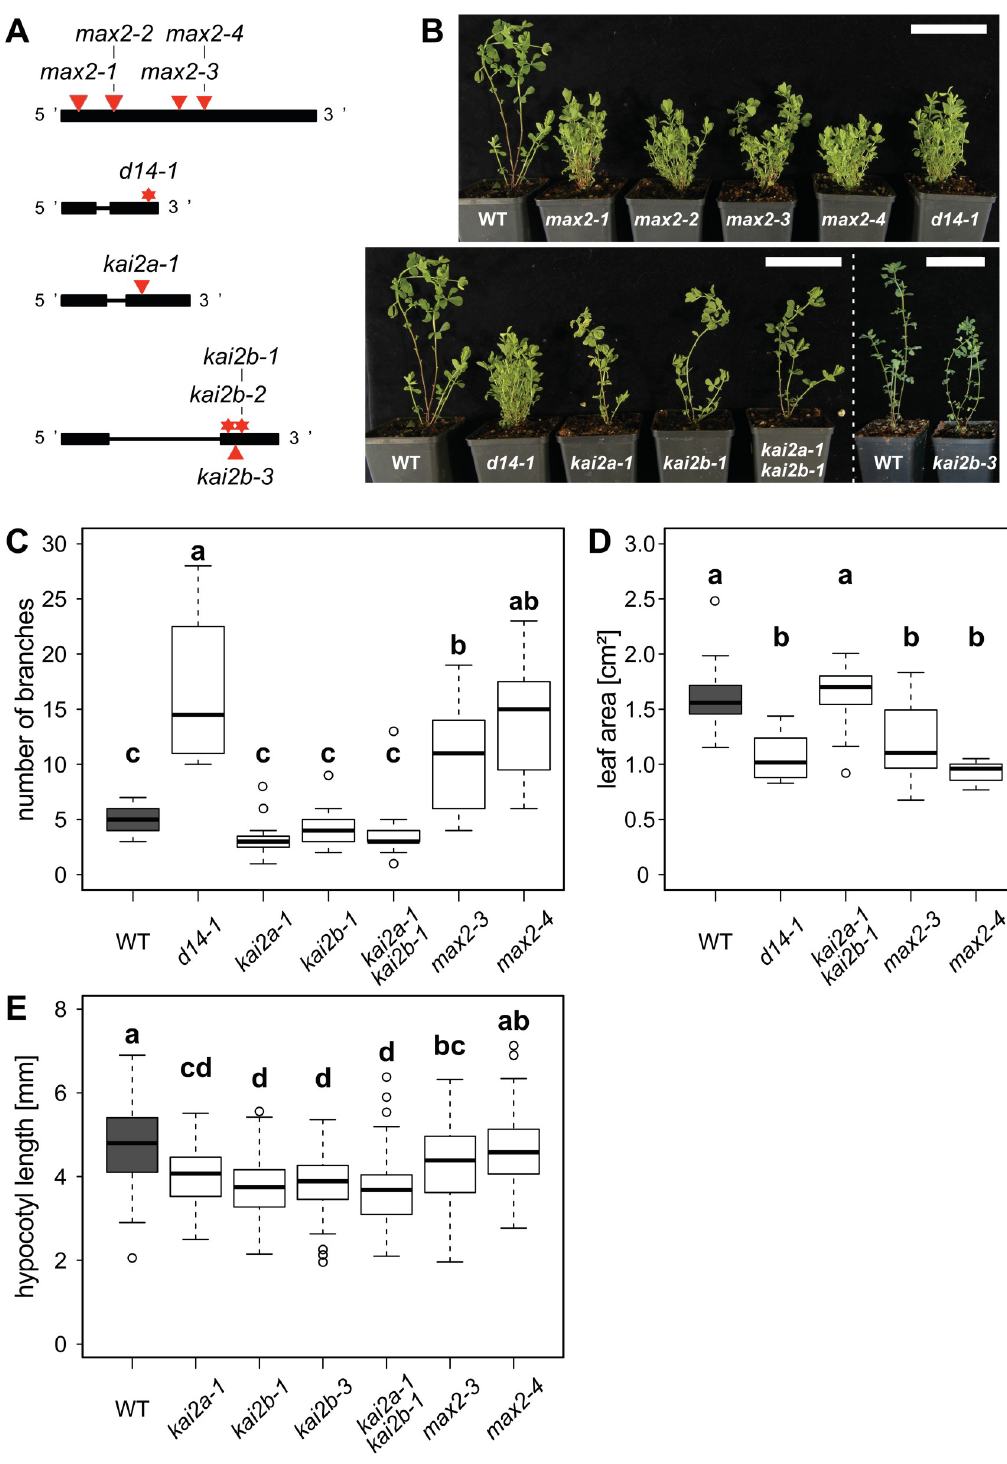
Fig 6. Role of D14 , KAI2a , KAI2b and MAX2 in shoot and hypocotyl development of Lotus japonicus . ( A ) Schematic representation of the L . japonicus D14 , KAI2a , KAI2b and MAX2 genes. Black boxes and lines show exons and introns, respectively. LORE1 insertions are indicated by red triangles and EMS mutations by red stars. ( B ) Shoot phenotype of L . japonicus wild-type and karrikin and strigolactone perception mutants at 8 weeks post germination (wpg). Scale bars: 7 cm. ( C ) Number of branches and of L . japonicus wild-type, karrikin and strigolactone perception mutants at 7 wpg (n = 12–21). ( D